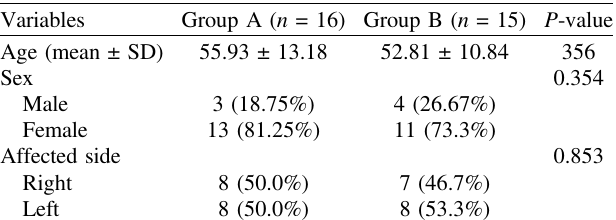
Figure 3. Research sampling fl ow. This study retrospectively observed and followed 31 patients. The samples were divided into two groups in the study. Group A received hydrodilatation with saline and corticosteroid injection without suprascapular nerve block augmentation at the spinoglenoid notch. Group B received hydrodilatation with saline, corticosteroid injection, and suprascapular nerve block augmentation at the spinoglenoid aperture. Groups A and B consisted of 16 and 15 patients, respectively. Table 1. Baseline characteristics. Table 3. Comparison of Delta scores before and after procedure between time periods.